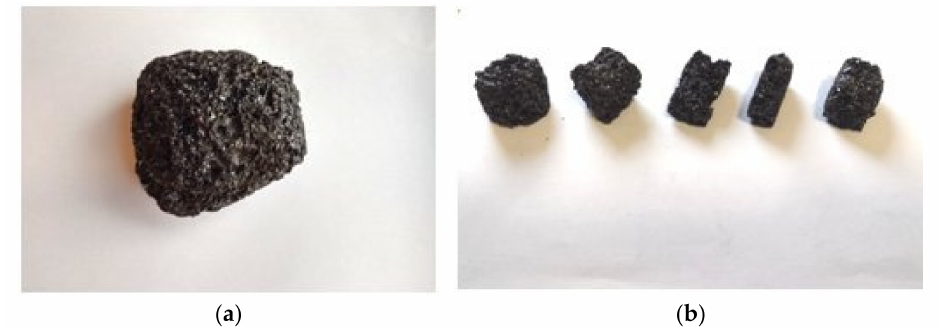
Figure 2. ( a ) Raw recyclate; ( b ) Preparation of experimental